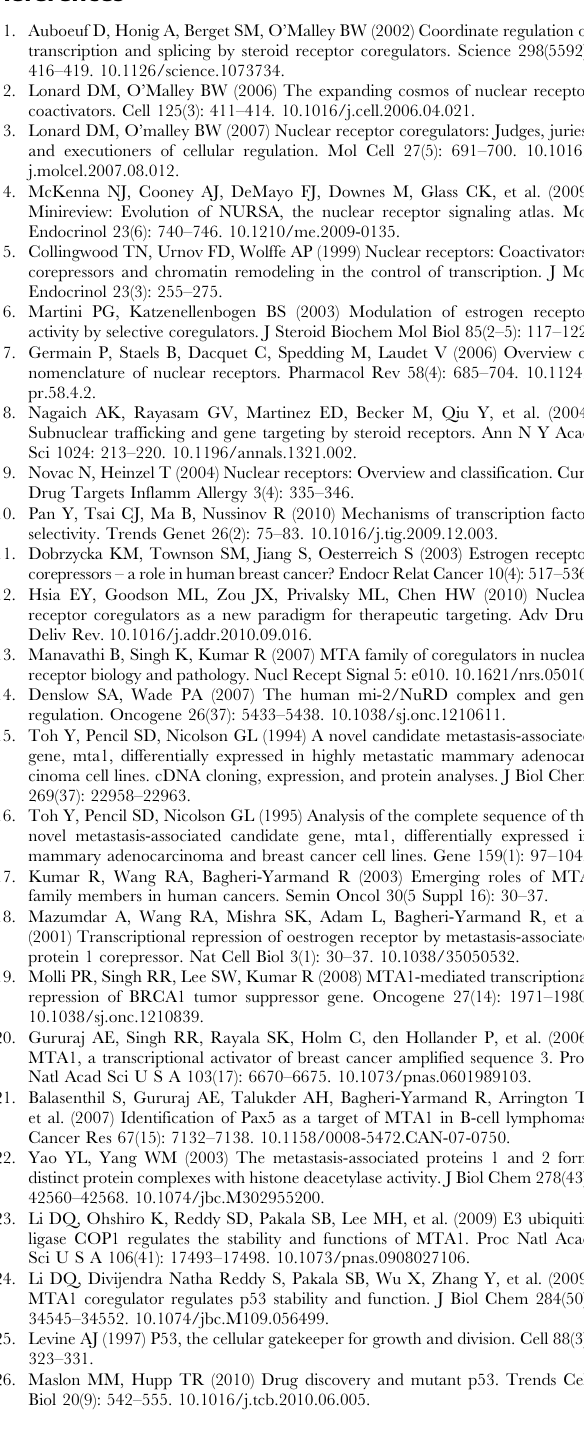
Table S9 Gene Ontology analysis of the ‘bona fide’ Mta1 regulated genes in the absence of P53 with $ 2.0 fold change.